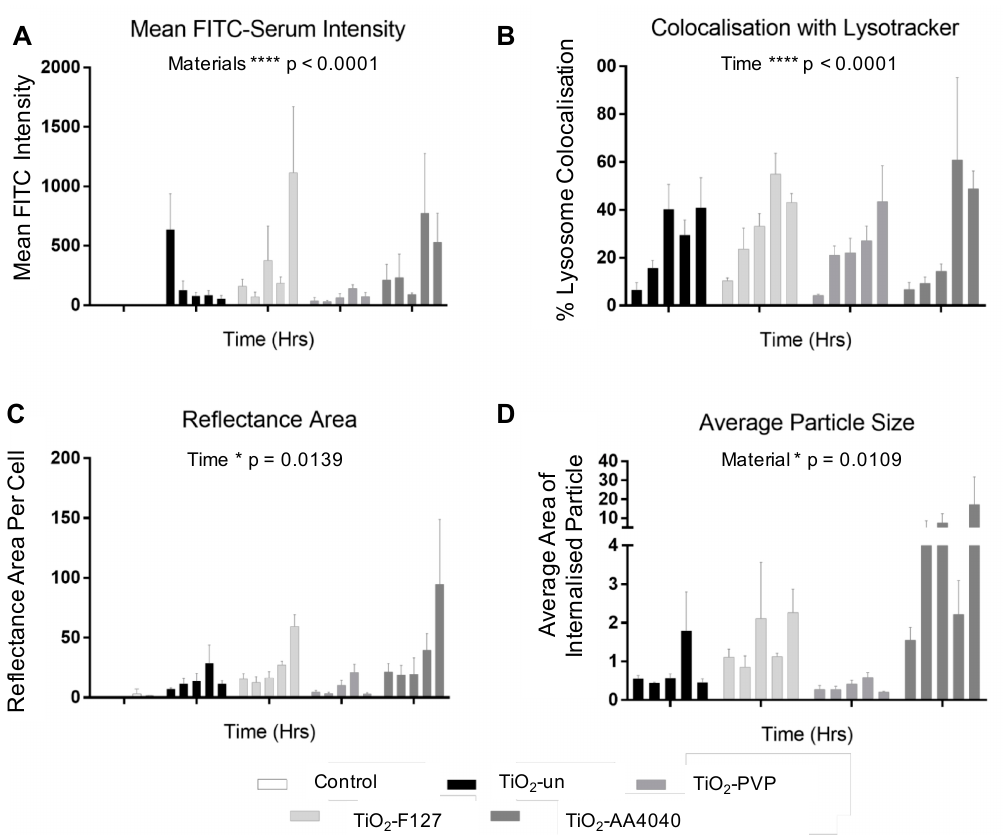
Figure 5. ( A ) Quantification of confocal data at 0, 2, 6, and 24 h post-exposure shows a change in the FITC-serum signal over time. While TiO 2 -un NMs rapidly lose the FITC-serum signal, surface-modified particles retain this, with a steady increase over time. TiO 2 -PVP demonstrates a slight reduction in signal between 18 and 24 h, potentially indicative of lysosomal degradation. ( B ) All four NMs demonstrate a steady increase in lysosomal co-localization, with significance demonstrated over time (**** p < 0.0001), but not between materials. ( C ) An increase in the reflectance area over time, indicative of NM uptake, is observed (* p = 0.0139), with no significant difference in NMs observed, consistent with the equivalent exposure of each NM type to the cells in question. ( D ) Finally, a difference in NM agglomerate size (in microns) is noted between materials (* p = 0.0109) consistent with images which show TiO 2 -PVP internalized as small discrete agglomerates, compared to the larger agglomerates of TiO 2 -F127 and TiO 2 -AA4040 observed (two-way ANOVA, SEM, n = 3).